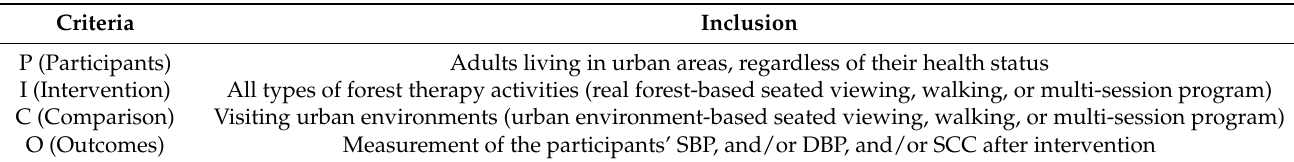
Table 1. Inclusive criteria for the